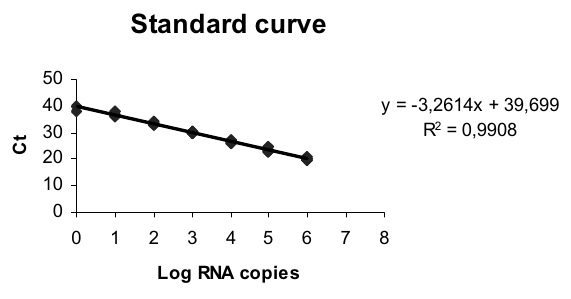
Fig. 1 – Standard curve for in vitro transcribed RNA. The standard curve was derived by linear regression including all Ct values shown in Table I. In the equation ( y = ax + b ), a represents the slope (–3.3144) and b the intersection at the y axis (39.93); R 2 indicates the correlation coeficient between the